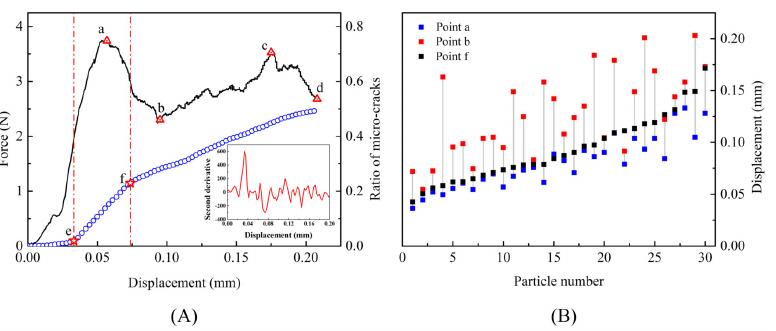
10 Figure 10. ( A ) Change in the microcrack growth rate during the loading process; ( B ) the relationships between points a, b, and